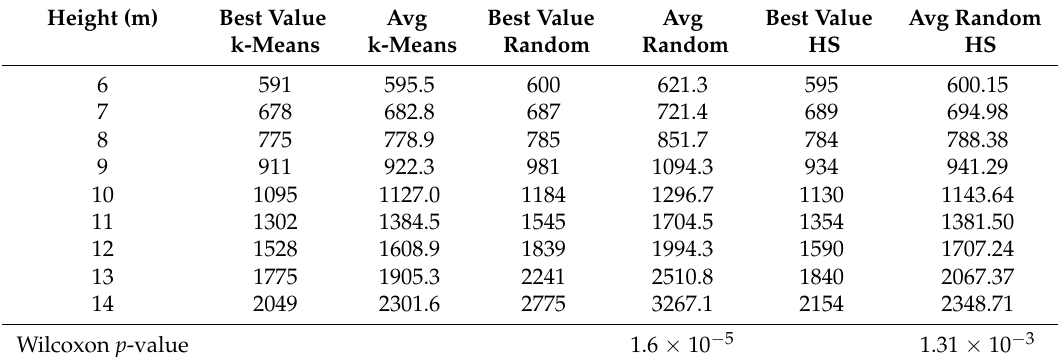
Table 5. Comparison between random and k-means operators in cost